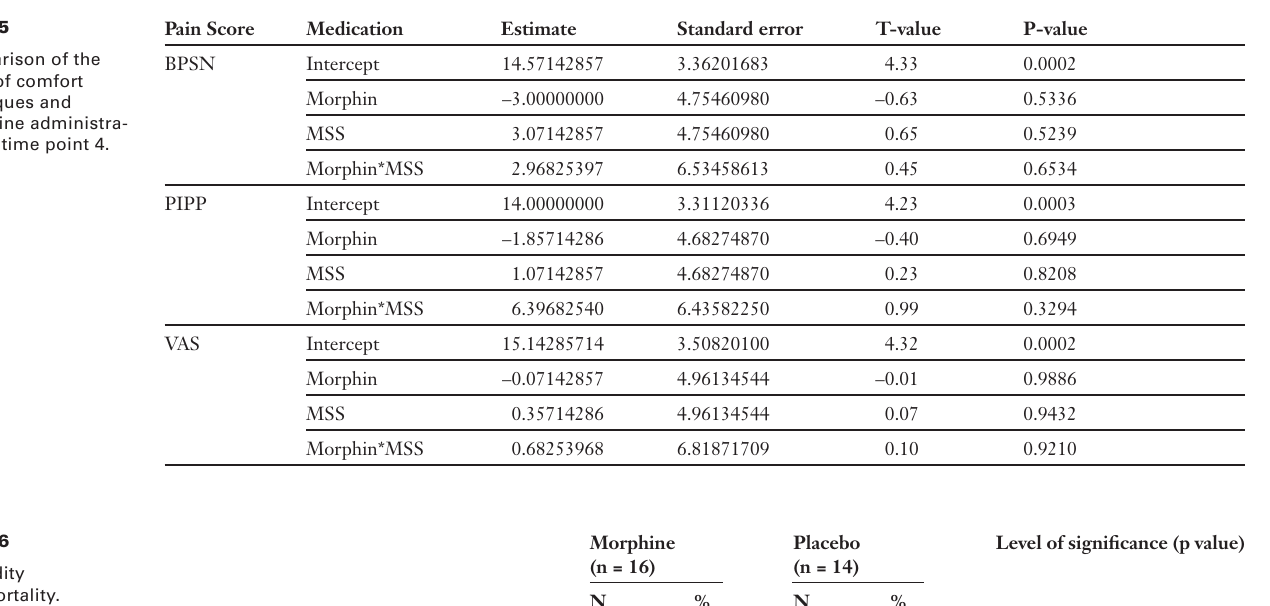
Morbidity and mortality.